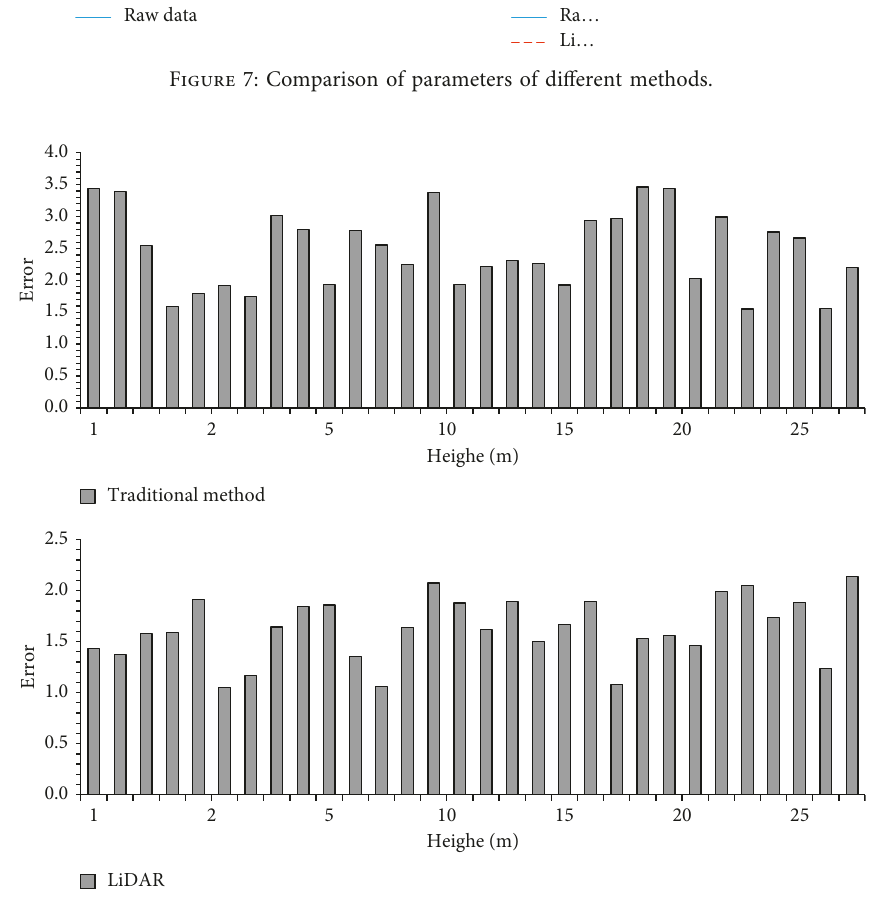
Figure 8: Data error at different